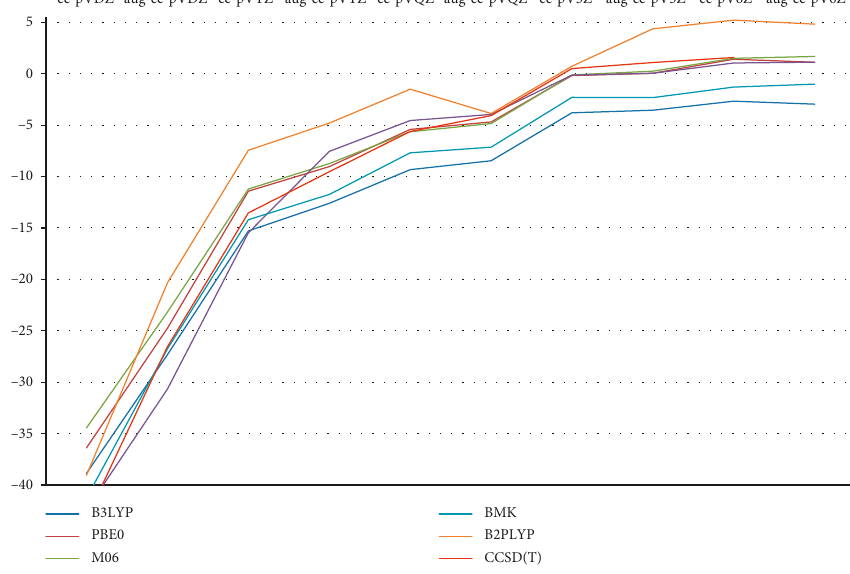
Figure 13: Free energy difference (in kcal/mol) between the ClOO and OClO isomers at their optimum geometries, calculated with several methods using cc and aug-cc basis